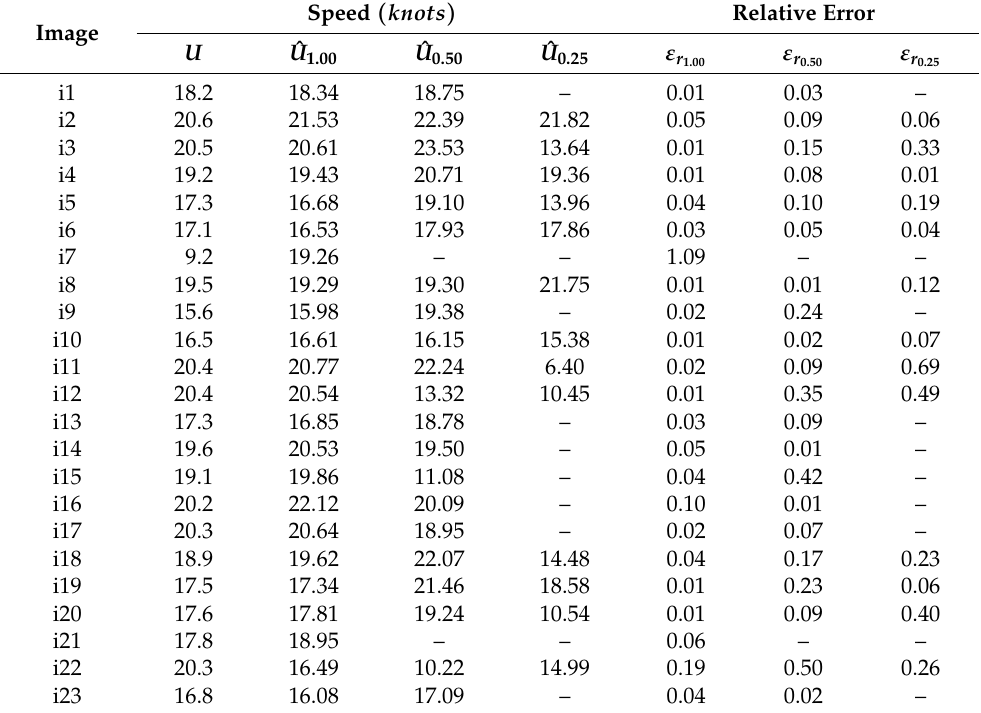
Table 3. Variation in the estimated speeds as a function of image resolution: U is the speed that was measured by the radar; ˆ U s and ε r are the speed that was estimated by our approach and the s relative error that was obtained using an input image at a scale of s , respectively; and s = 1.0 for the original images. Image